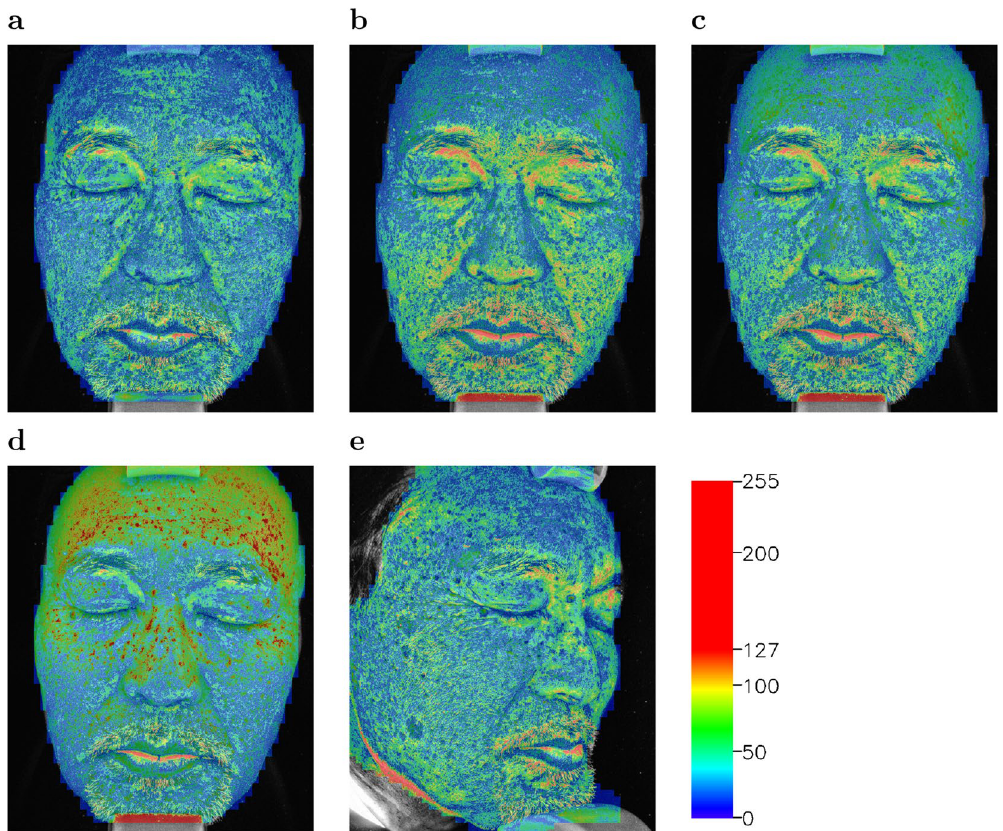
Figure 3. Heatmap images indicating pixel-wise L1 distance from the UV photo image for ( a ) the synthetic UV image by UV-phot Net, ( b ) the image by the ICA-based method, ( c ) the blue channel image, and ( d ) the grayscale image for a front face as well as ( e ) the synthetic UV image by UV-photo Net for a right profile face.